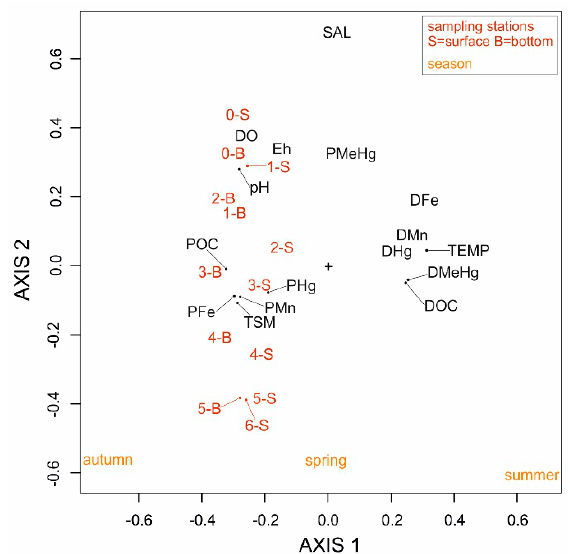
Figure 3. Plot summarising the results of 3W-PCA performed on dissolved and particulate Hg, MeHg, Fe and Mn as well as DOC, POC and physico-chemical parameters measured in the water column along the Nalón River estuary under different seasonal conditions (spring, summer and autumn).